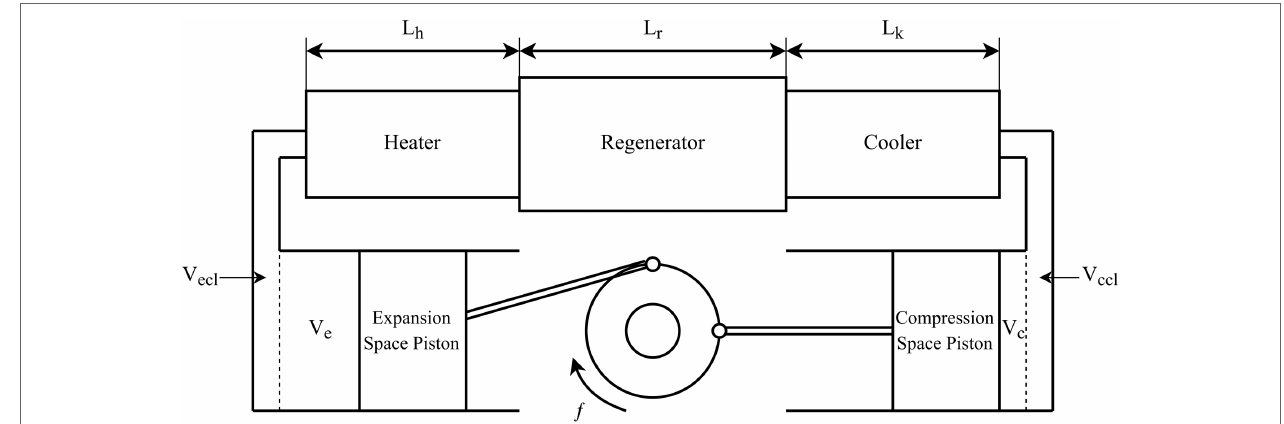
FIGURE 1 | Diagram of the alpha type Stirling